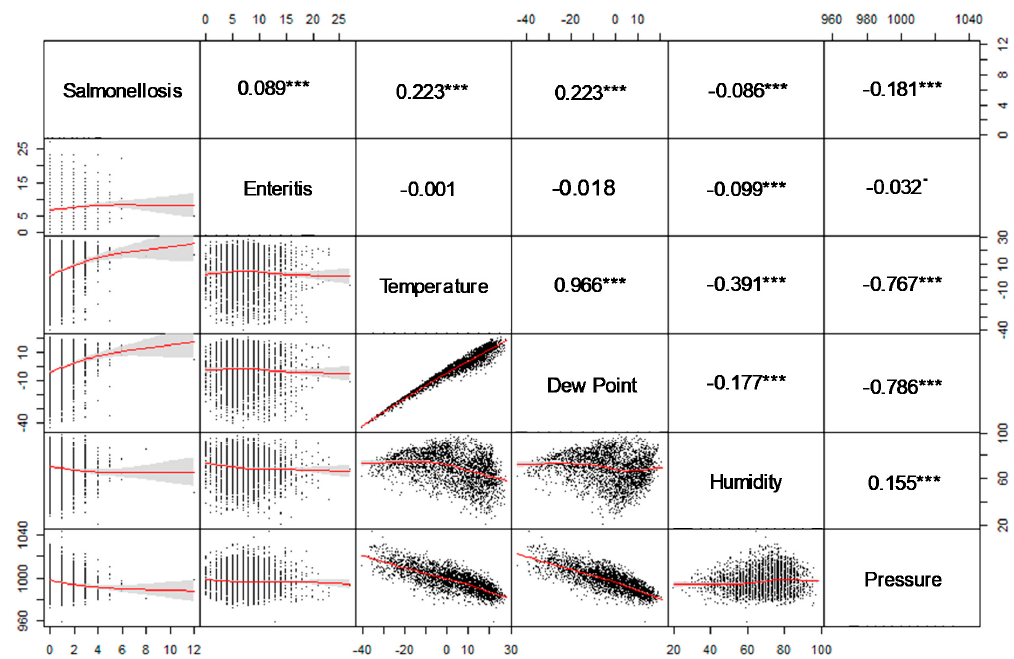
Figure 9. A scatter-plot matrix for health outcomes and weather variables and pair-wise Spearman correlation. *** p < 0.001, * p < 0.1.